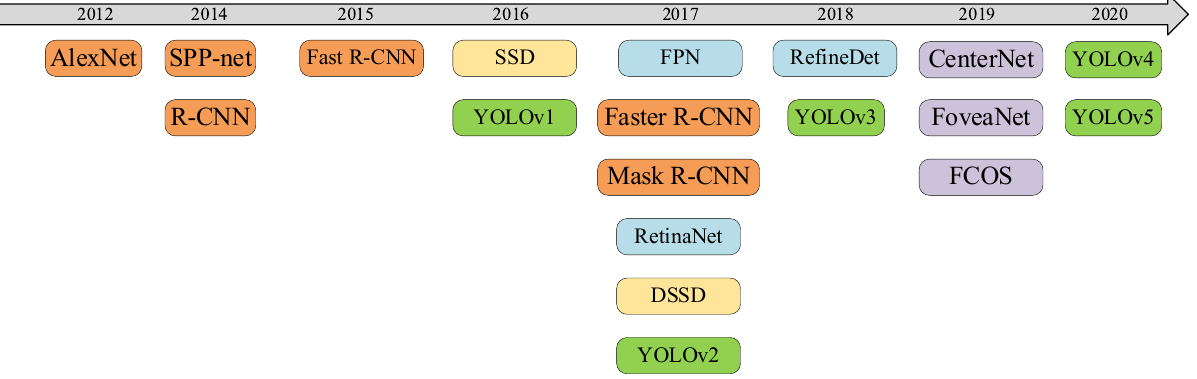
Figure 2. The development route of the DL object detection